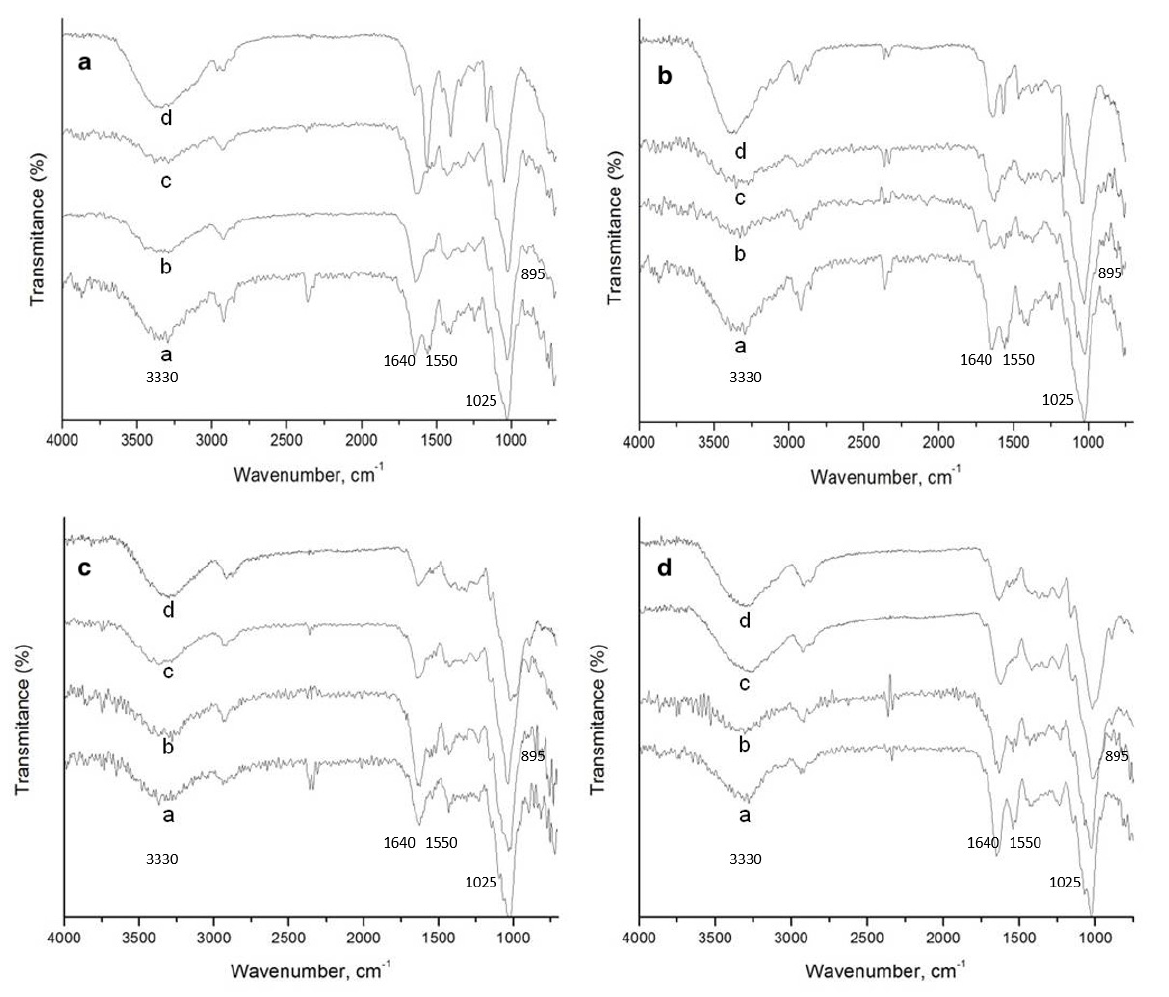
Figure 5. FTIR spectra of soybean hull treated with [bmim][Ac] (a and c), and [bmim][Cl] (b and d), for 2 h (a and b), and 6 h (c and d). Legend: a) untreated biomass, b) IL 50 % and 75 °C, c) IL 100 % and 75 °C, and d) IL 100 % and 100